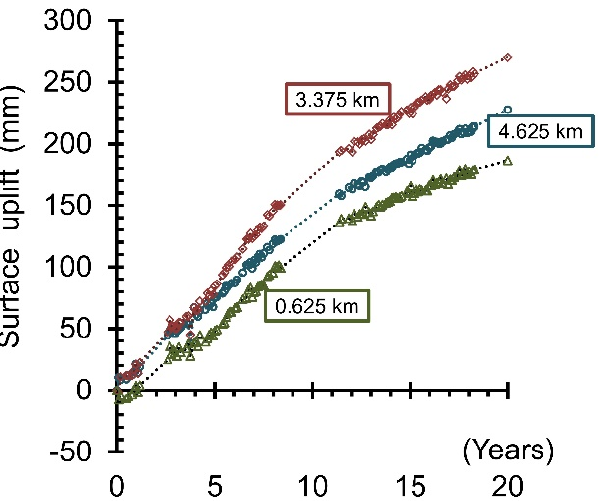
Figure 6. Variation of the uplift as a function of time from August 1992 onwards over a period of 20 years based on InSAR data. The mean curves are presented for 10 reflectors closest to a central point: green curve around a north–south coordinate equal to 0.625 km, burgundy curve around 3.375 km, and blue curve around 4.625 km. In Figure 7, the relation between water level and uplift is presented for both sets of calculations. The increase in uplift at a north–south coordinate of 3.375 km (the location of the maximum uplift) is expressed as a percentage of the maximum calculated value at that location. For the framework developed by [17], the increase in water pressure corresponds to the change in pressure at a coordinate of 3.375 km. At that location, the depth of the bottom element is 725 m. In other words, the maximum (100%) is reached for 7.25 MPa. For the situation corresponding to an open reservoir, the increase in water pressure refers to the deepest point of the reservoir, i.e., a depth of 775 m in the northern part of the mined area. In other words, the maximum (100%) is reached for 7.75 MPa. As mentioned earlier, the relation for the original framework is linear (Figure 7, purple diamonds). The one corresponding to an open reservoir is not linear (Figure 7, green circles).